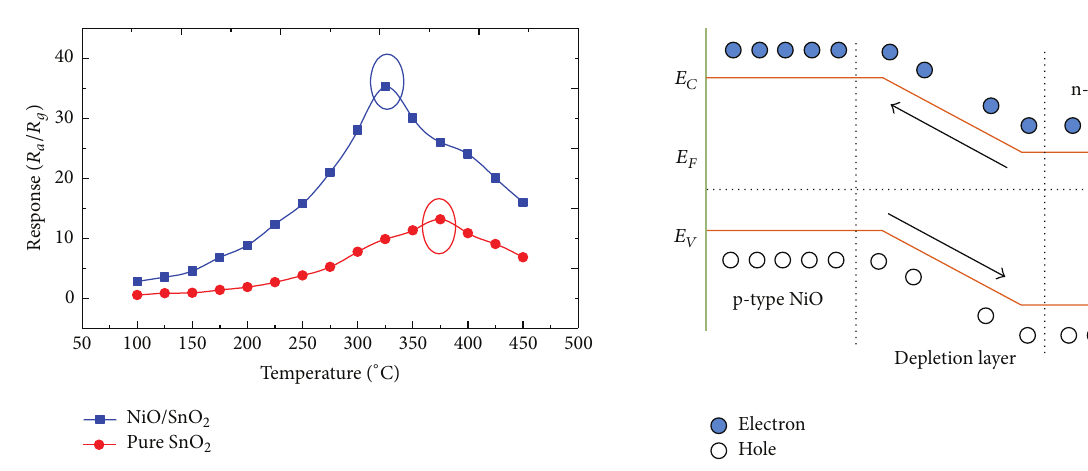
Figure 8: Energy band structure diagram of NiO/SnO 2 p-n hetero- junction ( 𝐸 𝐶 : lower level of conduction band, 𝐸 𝐹 : Fermi level, and 𝐸 𝑉 : upper level of valence